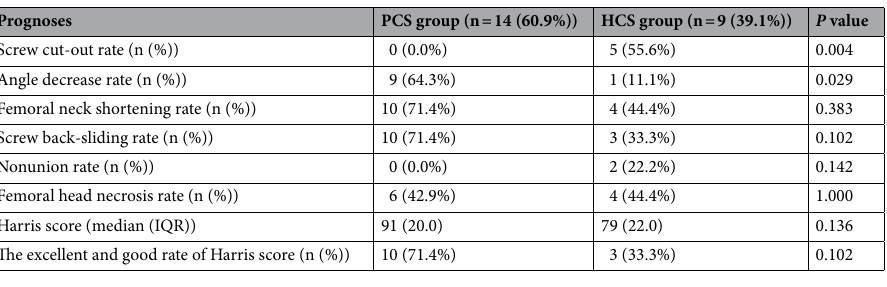
Table 9. Prognoses of patients with different internal fixation groups in displaced fractures. IQR stands for interquartile